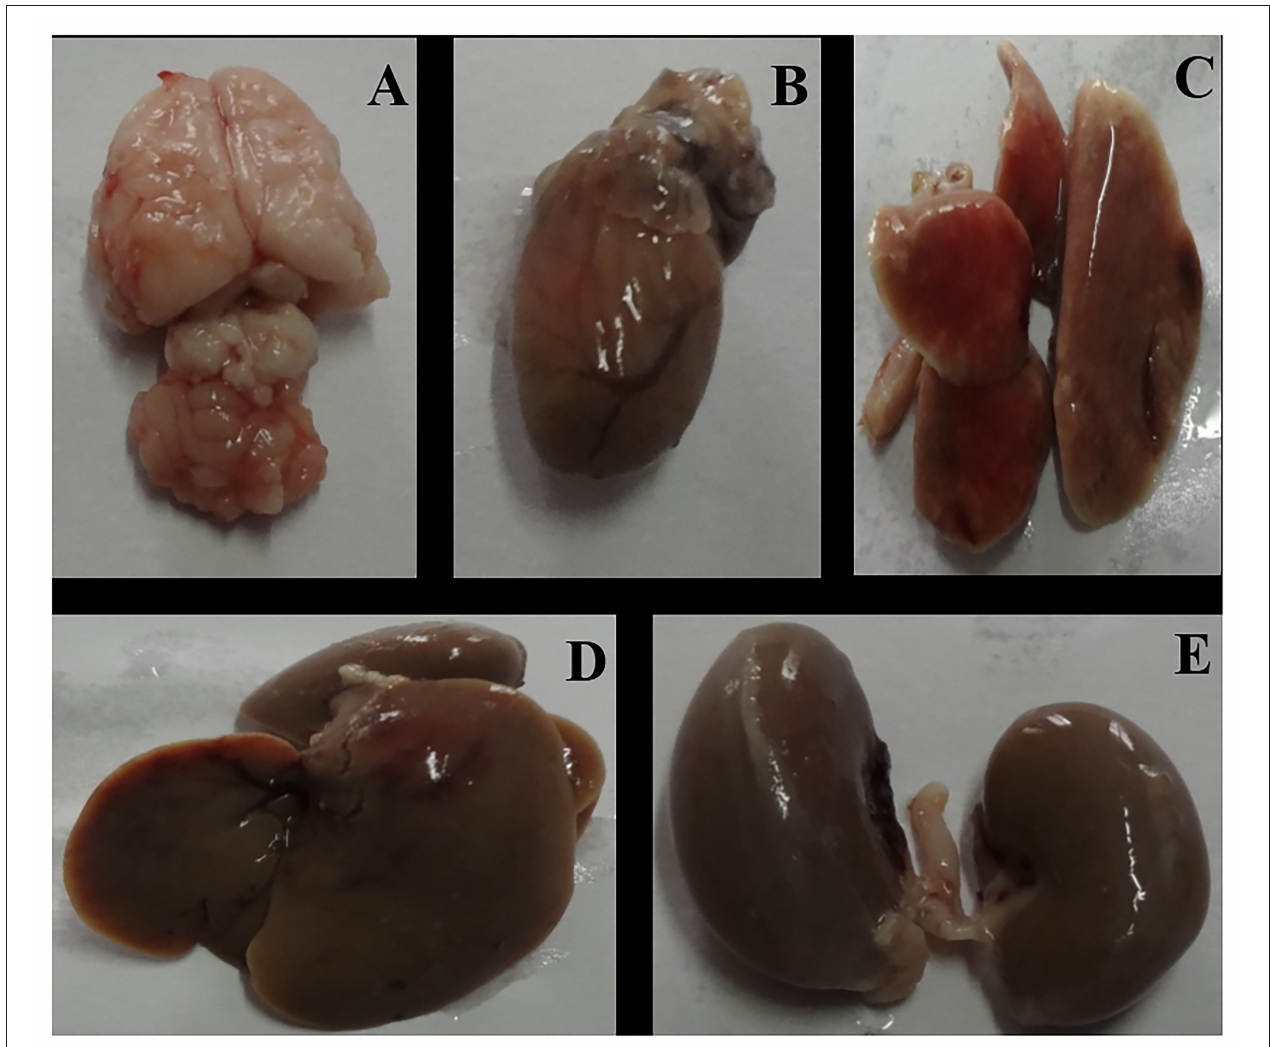
FIGURE 7 | Gross necropsy of albino Wistar rat, organs of experimental (Group C) animal [ (A) Brain, (B) Heart, (C) Lung, (D) Liver, (E)